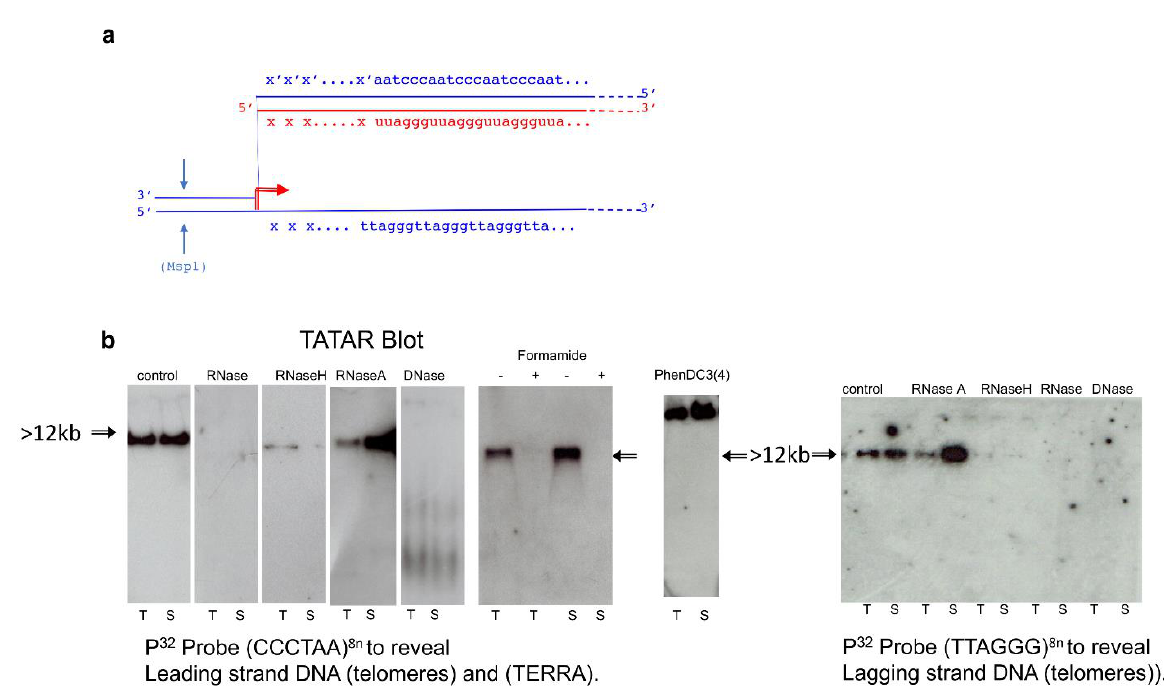
Figure 2. The telomeric TERRA complex (DNA/RNA hybrid). ( a ) A simplified R-loop model. TERRA (red line) is assumed to originate from a subtelomeric promoter (red arrow); blue lines: telomere and sub-telomere DNA; “xxx”: 5′ TERRA sequence from subtelomeric DNA (xxx/x’x’x’); arrows: Msp1 cleavage. ( b ) Telomeres associated TERRA RNA detection after Msp1 cleavage performed as in Figure 1 on the indicated mouse cells (T: testis and S: sperm). Left to right: The complex shown in several conditions: control detection of the (TT/UU)AGGG containing fragments, in extracts treated before loading with -pancreatic (DNase free RNase ref. 11119915001), or-RNase 0.5 µg/µL (which remove all RNA), or-RNaseH 1 u/µL (ref. M0297S) to remove all RNA hybridized with DNA, or-RNaseA 1 u/µL (ref. 101091690 01) to remove single strand free RNA and/or DNase 10 u/µL, to remove all DNA respectively (all provided by Roche Life Science), and control electrophoresis after addition of either 50% formamide (denaturation conditions +/ or −) which denature all nucleic and ribonucleic acid or −20 µM phenylDC(3)4 (right) which blocks quadruplex. Nitrocellulose membrane filters were hybridized with two probes to reveal: at left P 32 Probe (CCCTAA) 8n Leading strand DNA (telomeres), (TERRA) and at right P 32 Probe (TTAGGG) 8n Lagging strand DNA (telomeres).